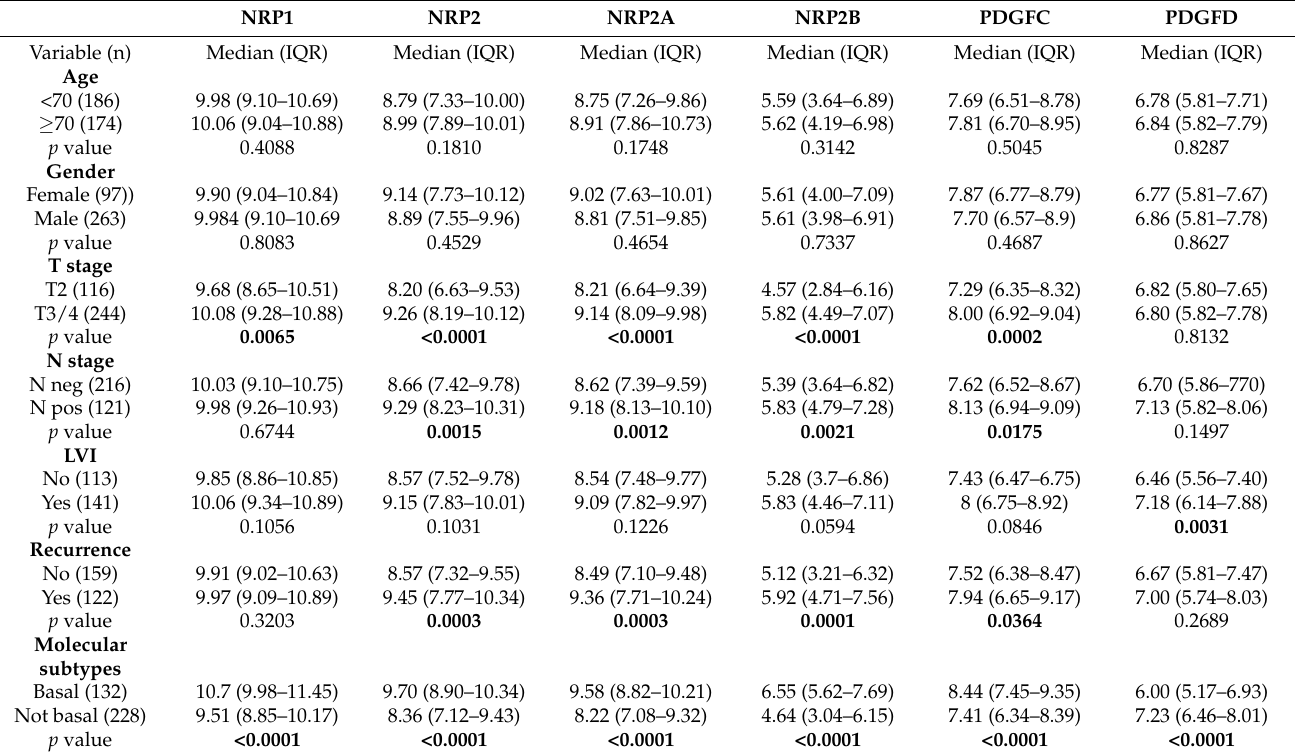
Table 2. Associations of gene expression with clinicopathological parameters in the TCGA cohort.